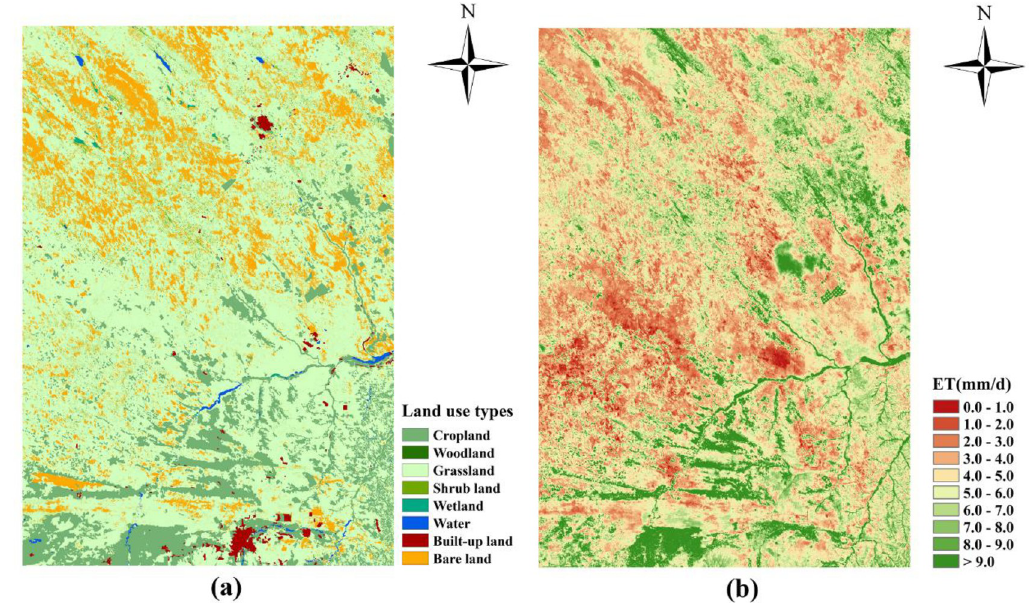
Fig 7. Spatial distribution of (a) land use types and (b) daily evapotranspiration in agro-pastoral ecotone of northwest China.